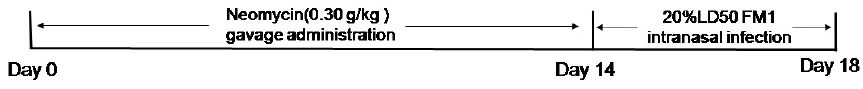
Figure 1. Time order of treatment for mice.